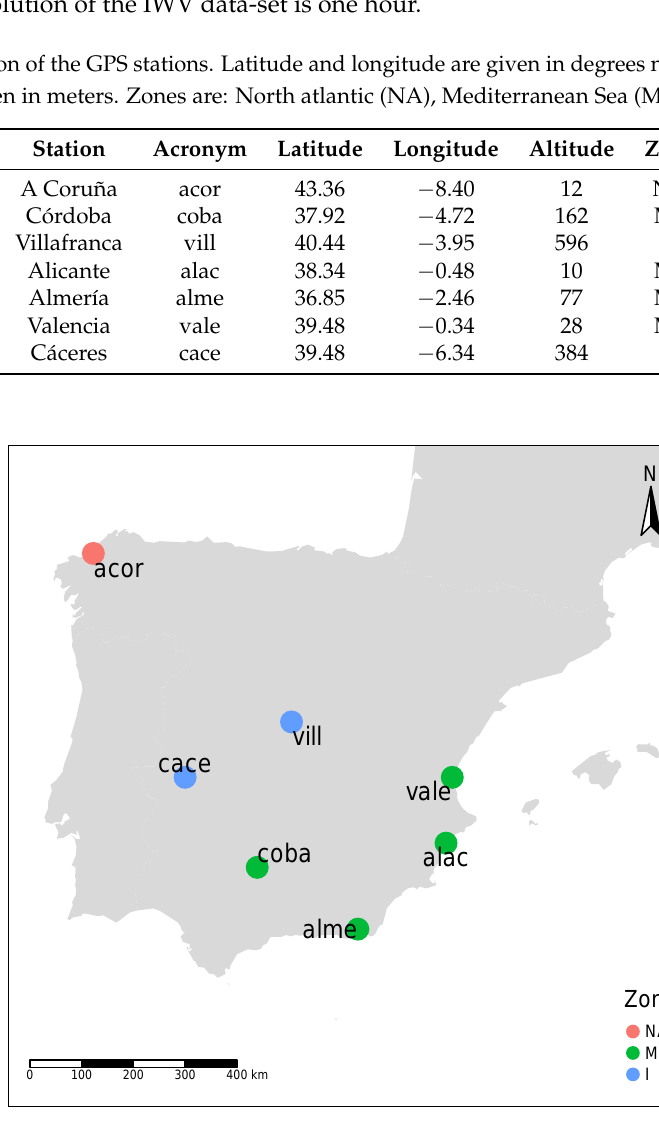
Figure 1. Map of the Global Positioning System (GPS) stations included in this work. Zones are: North atlantic (NA), Mediterranean Sea (MS) and interior